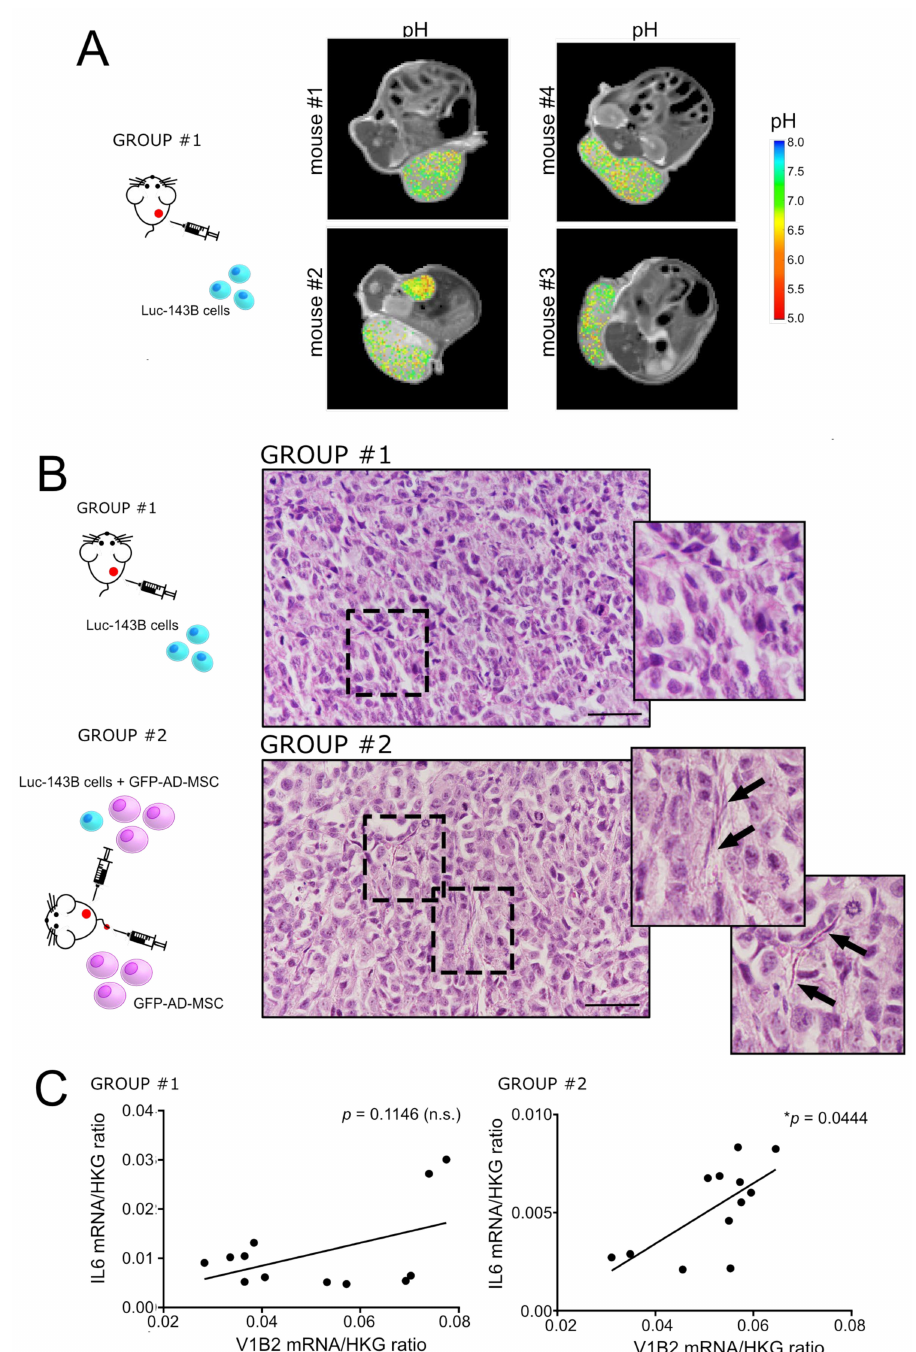
Figure 2. Intratumoural acidosis in subcutaneous OS promotes the expression of IL6 in tumour-associated MSC. ( A ) Repre- sentative tumour extracellular pH maps superimposed on anatomical T2w images for subcutaneous OS xenografts; in the same panel, the scheme of the experiment is also shown (trial n. 1, see Table 2); ( B ) Left side of the panel: representative scheme of the experimental animal trial n. 2 (see Table 2); right side of the panel: representative images of H&E staining of subcutaneous xenografts in animal trial 2, after the co-injection of AD-MSC and luc-143B OS cells (group #2) compared to xenografts obtained with homotypic cell population of tumour cells (group #1). Images with further magnification are shown in the right rectangle (arrows indicate cells with a fibroblast-like morphology); ( C ) Correlations of the mRNA expression levels of IL6 and V-ATPase V1B2 isoform in the xenografts of the two groups (Spearman correlation test, * p < 0.05, n =